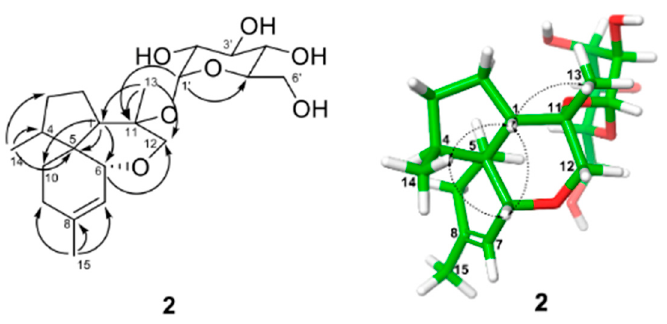
Figure 4. Key HMBC ( ) and NOESY ( ) correlations for 2 . The energy-minimized 3D struc- ture was obtained by Macromodel (Version 12.5, Schrodinger LLC) program. Table 1. NMR spectroscopic data (400 MHz, pyridine- d 5 ) for Compound 1 .